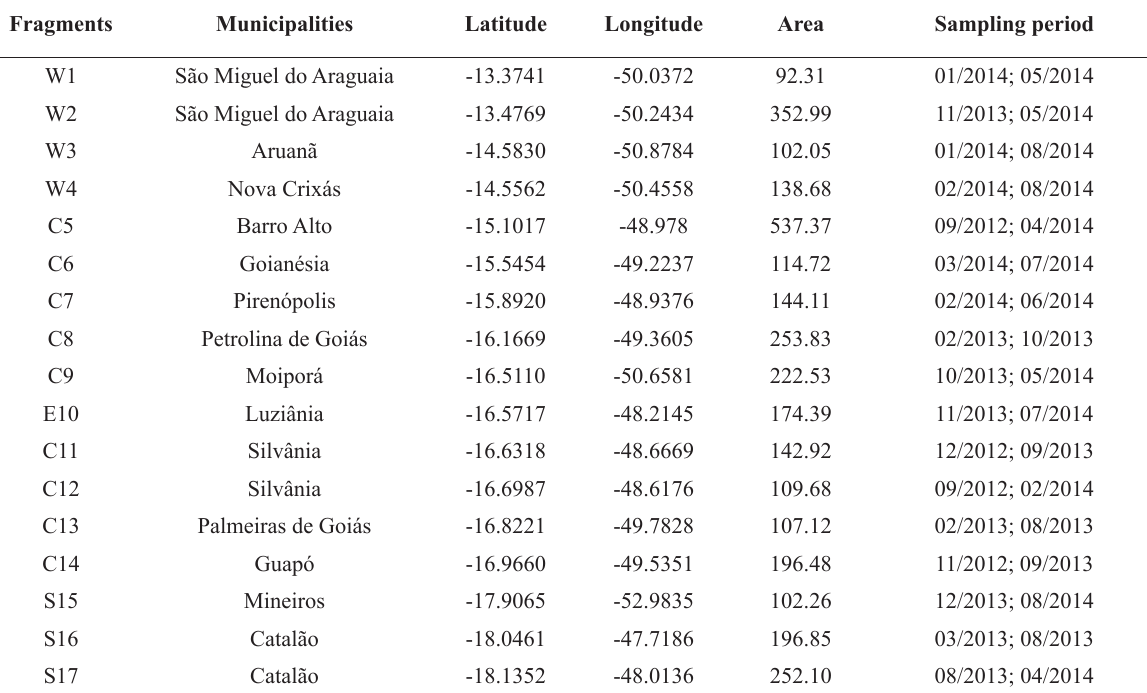
Sampled forest fragments and respective municipalities, geographical coordinates, area (hectares) and sampling period (month/year). The fragments are identified with the initial letters of the regions of the state (W: west; E: east; C: central; S: